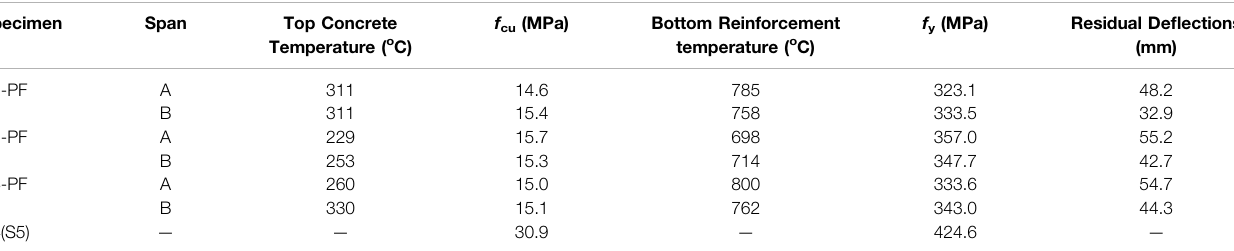
TABLE 1 | Maximum experienced temperature and residual de fl ections of the specimens.